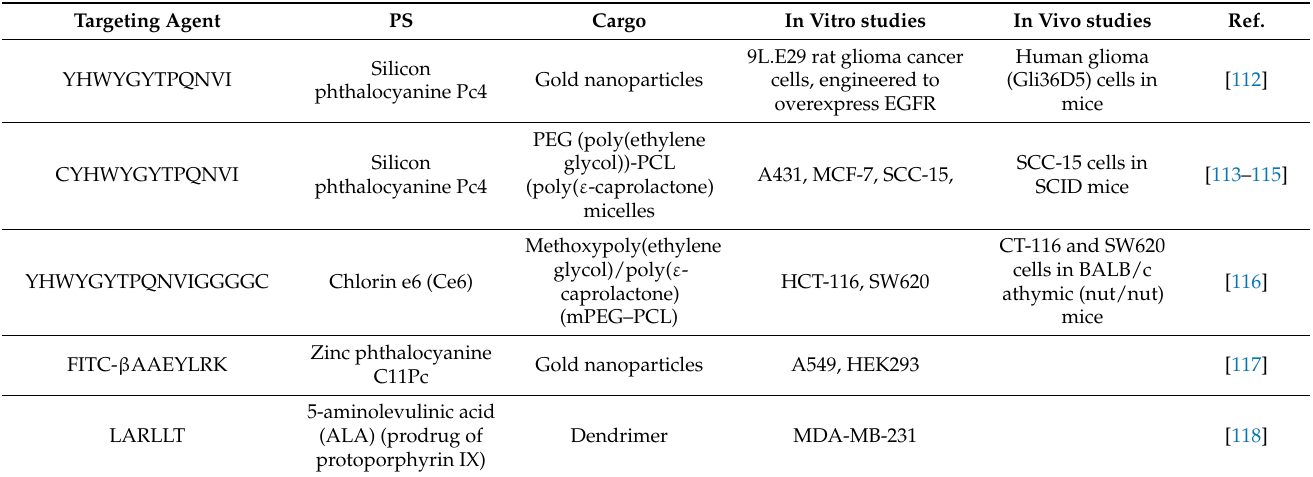
Table 4. EGFR-targeted PDT performed with anti-EGFR peptides conjugated with carrier